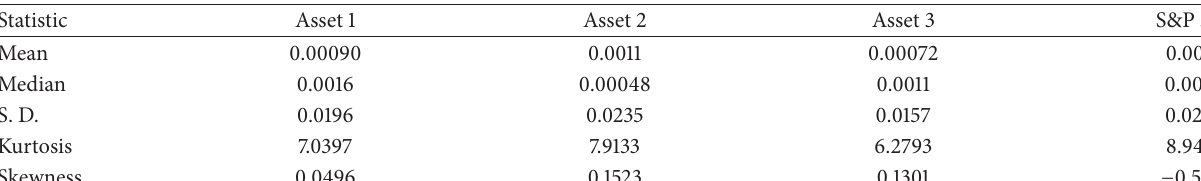
Table 2: The descriptive statistics.